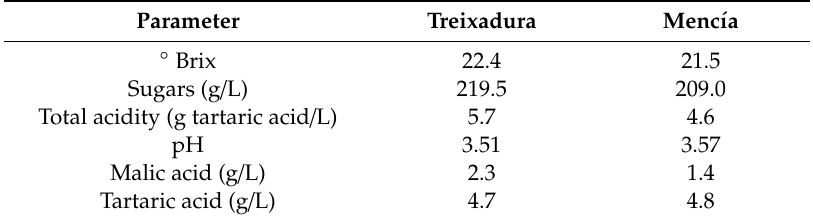
Table 1. Characteristics of Treixadura and Menc í a musts used in this